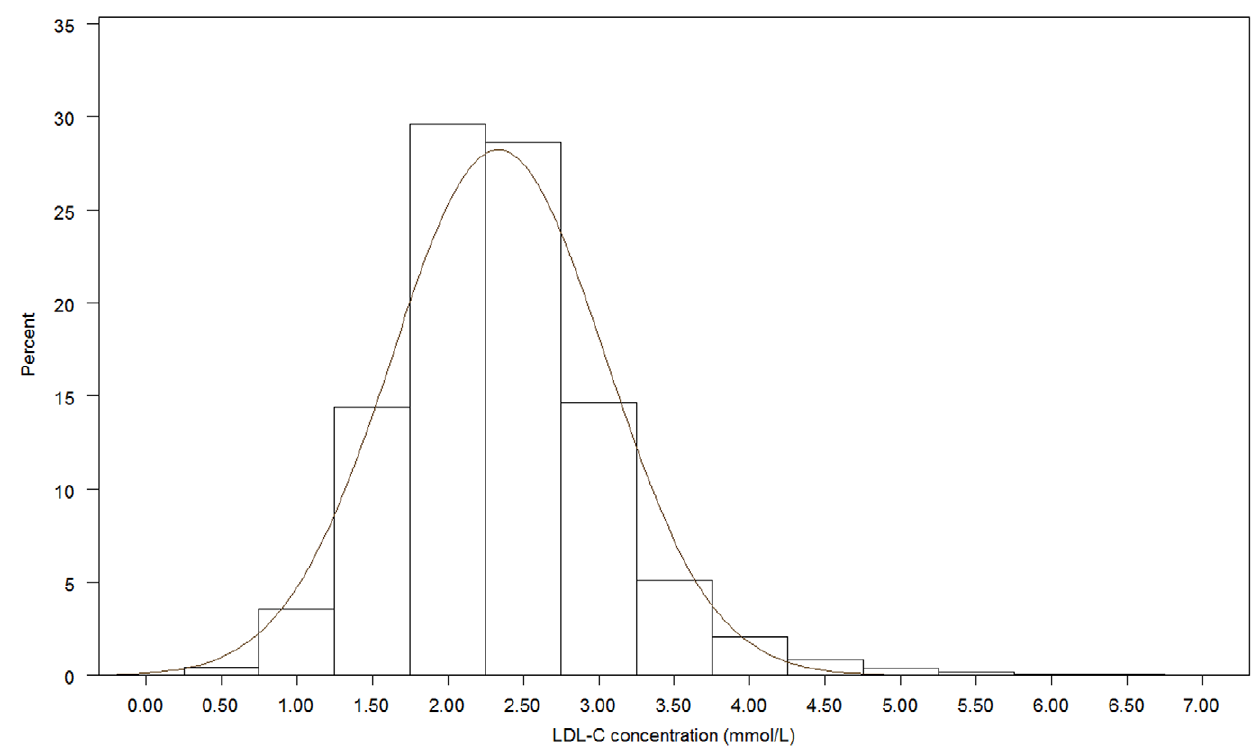
Figure 1. Histogram for the LDL-C values in patients on simvastatin.